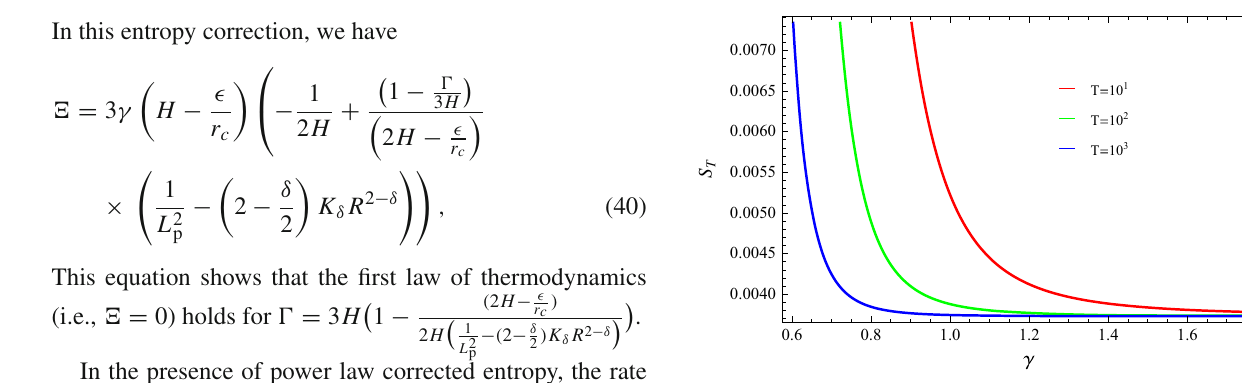
Fig. 7 Plot of total entropy versus γ